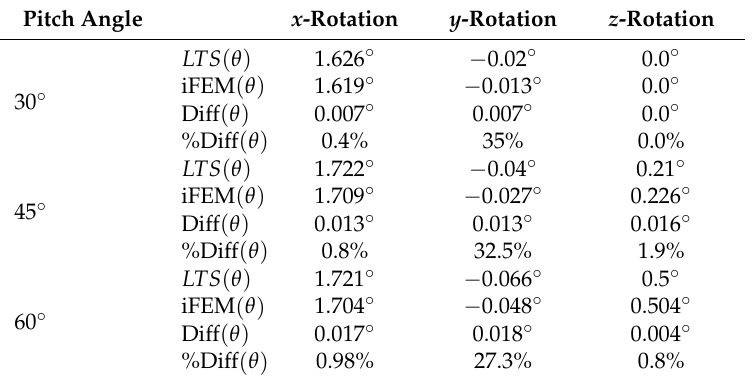
Table 4. The comparison of the fixed platform orientations at different pitch